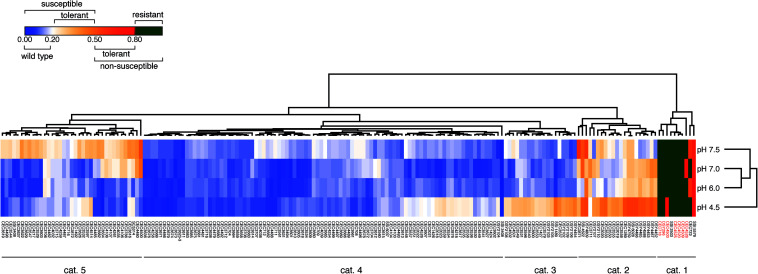
FLC tolerance screen of 181 C. albicans strains. The heatmap represents the mean TI values of at least 2 biological replicates. The “susceptible” and “non-susceptible” categories of the legend are based on the EUCAST definitions. Detailed results can be found in Supplementary File S1. Heatmap was generated with Morpheus (https://software.broadinstitute.org/morpheus/) with Euclidian distance metrics and average linkage method including hierarchical clustering on TI values and pH conditions. Red labeled isolate names correspond to isolates with known azole resistance mechanisms (Supplementary File S1).